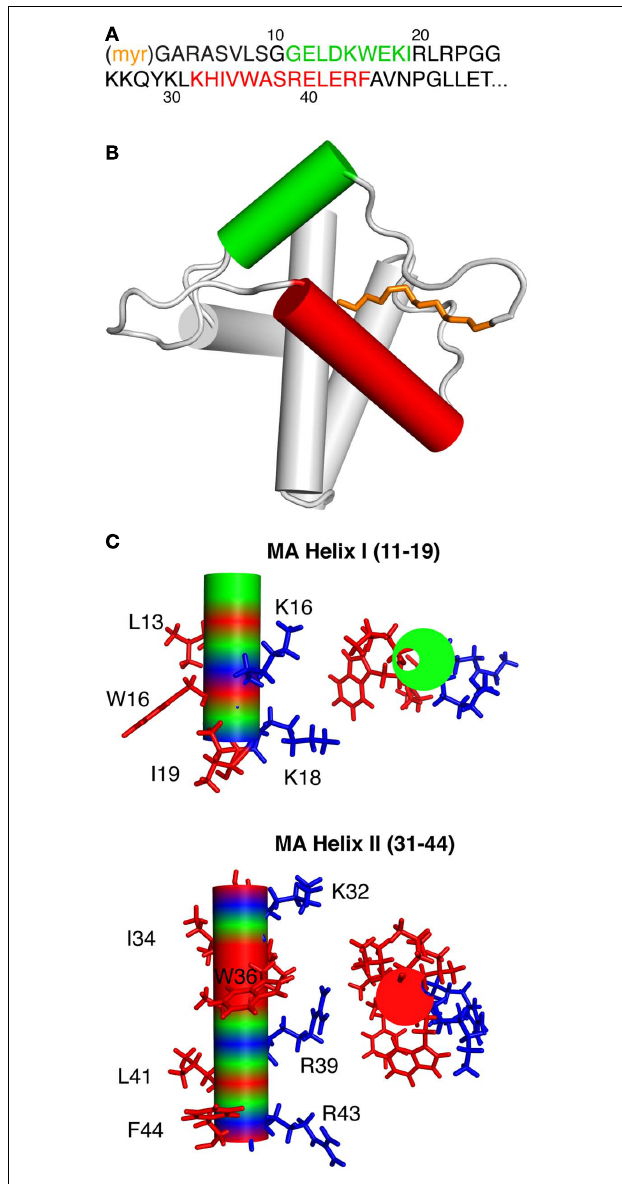
FIGURE 6 | (A) Amino acid sequence of the N-terminus of MA. (B) Cartoon representation of the NMR structure (2H3I) of myr( + )MA highlighting helices I and II in green and red, respectively. Myr group is shown in orange. (C) Amphipathic character of helices I and II with hydrophobic and basic residues shown in red and blue, respectively, “A modified version of this figure was published in the Journal of Biological Chemistry. Samal et al., 2011;The American Society for Biochemistry and Molecular